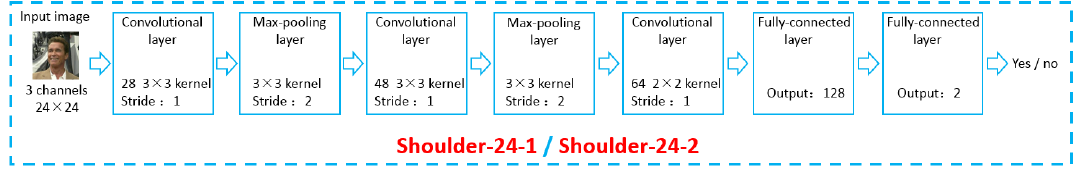
Figure 4. The CNN structure of Shoulder-24-1 and Shoulder-24-2.